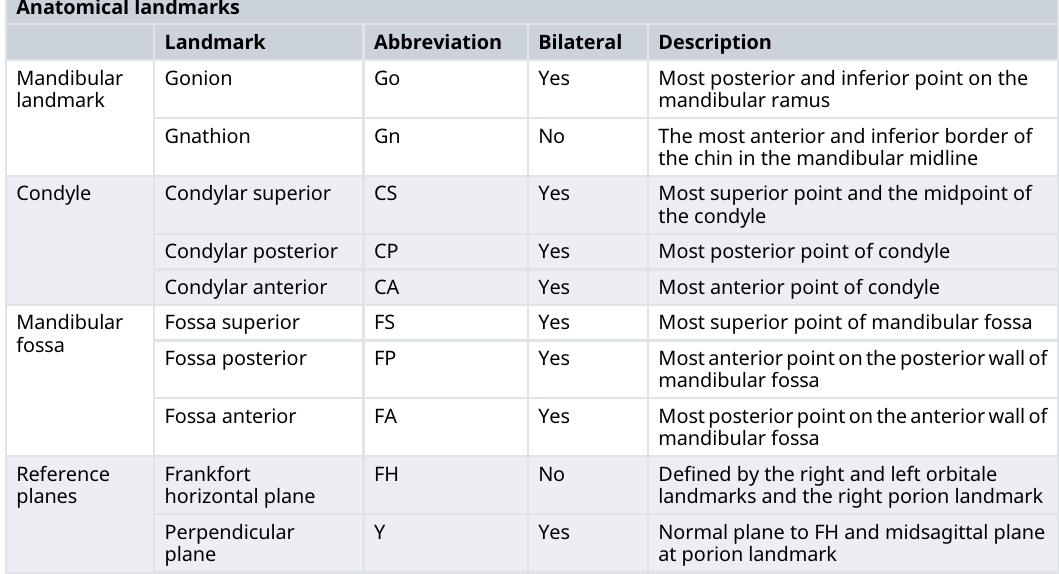
Table 1. Definitions of the anatomical landmarks and Reference planes.* Anatomical landmarks